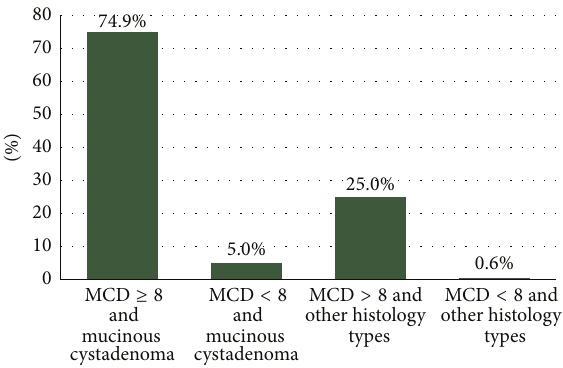
Figure 3: Probabilities of rupture in relation to MCD (cm) and cyst histology.